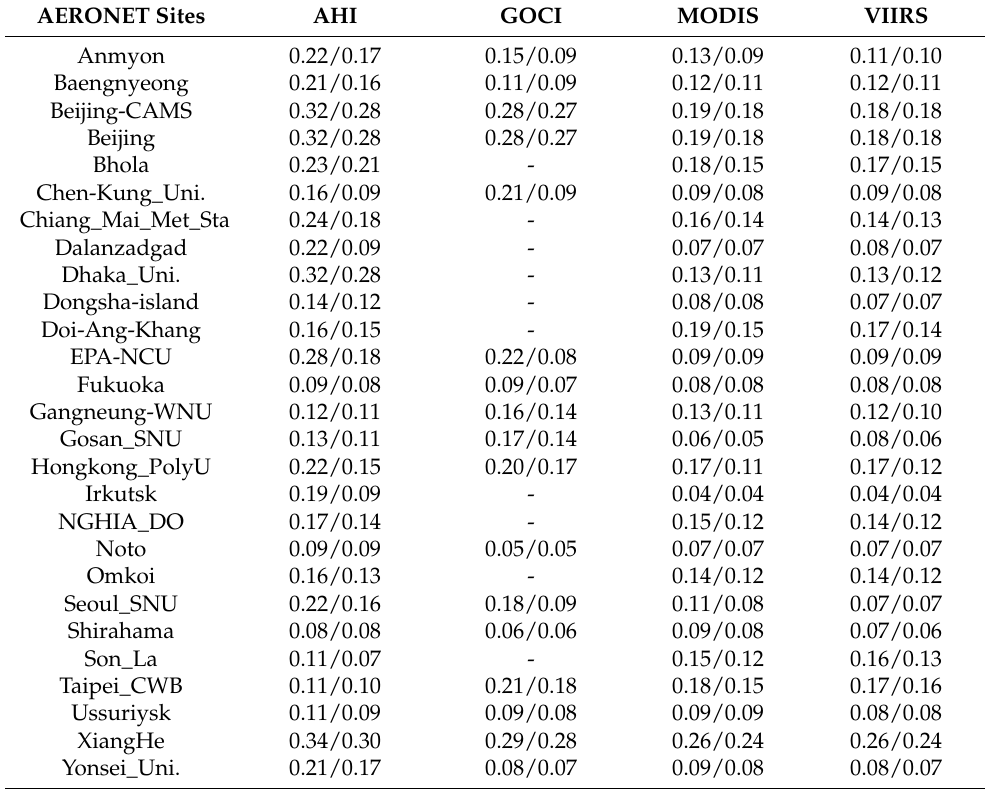
Table 3. Statistical error analysis (RMSE) for each satellite imager based on the selected AERONET sites, before/after applying the CDF